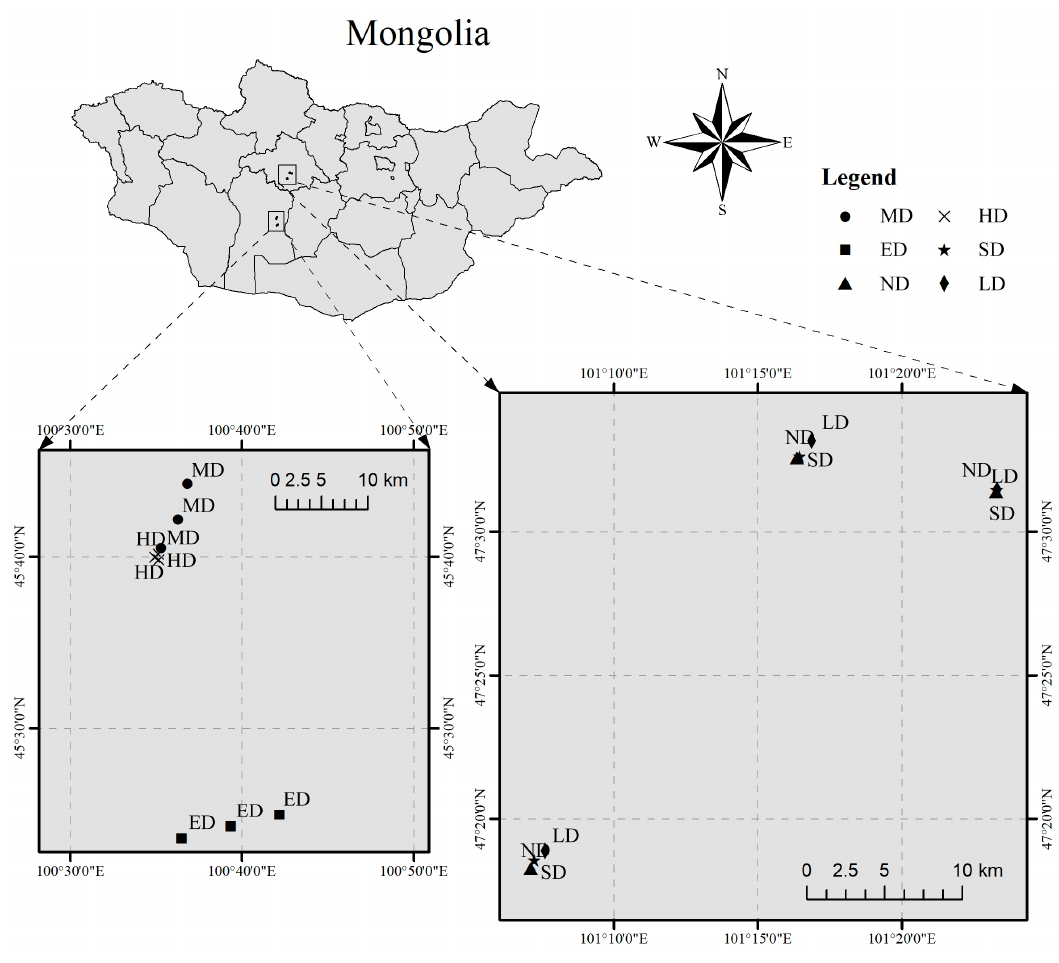
Figure 1. Sampling sites